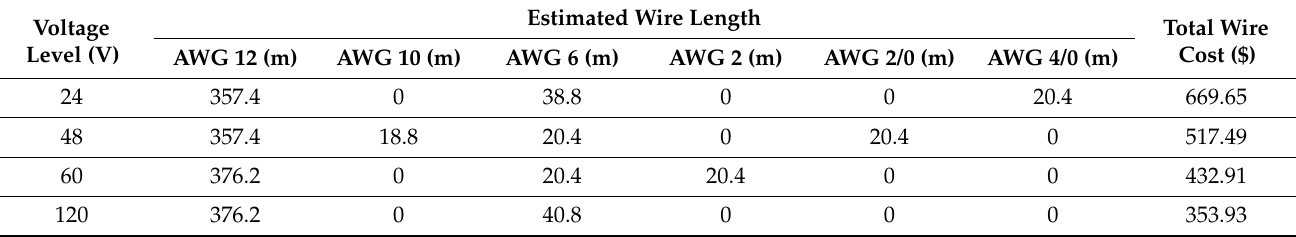
Table 3. Wire size, length, and total wire cost at each voltage